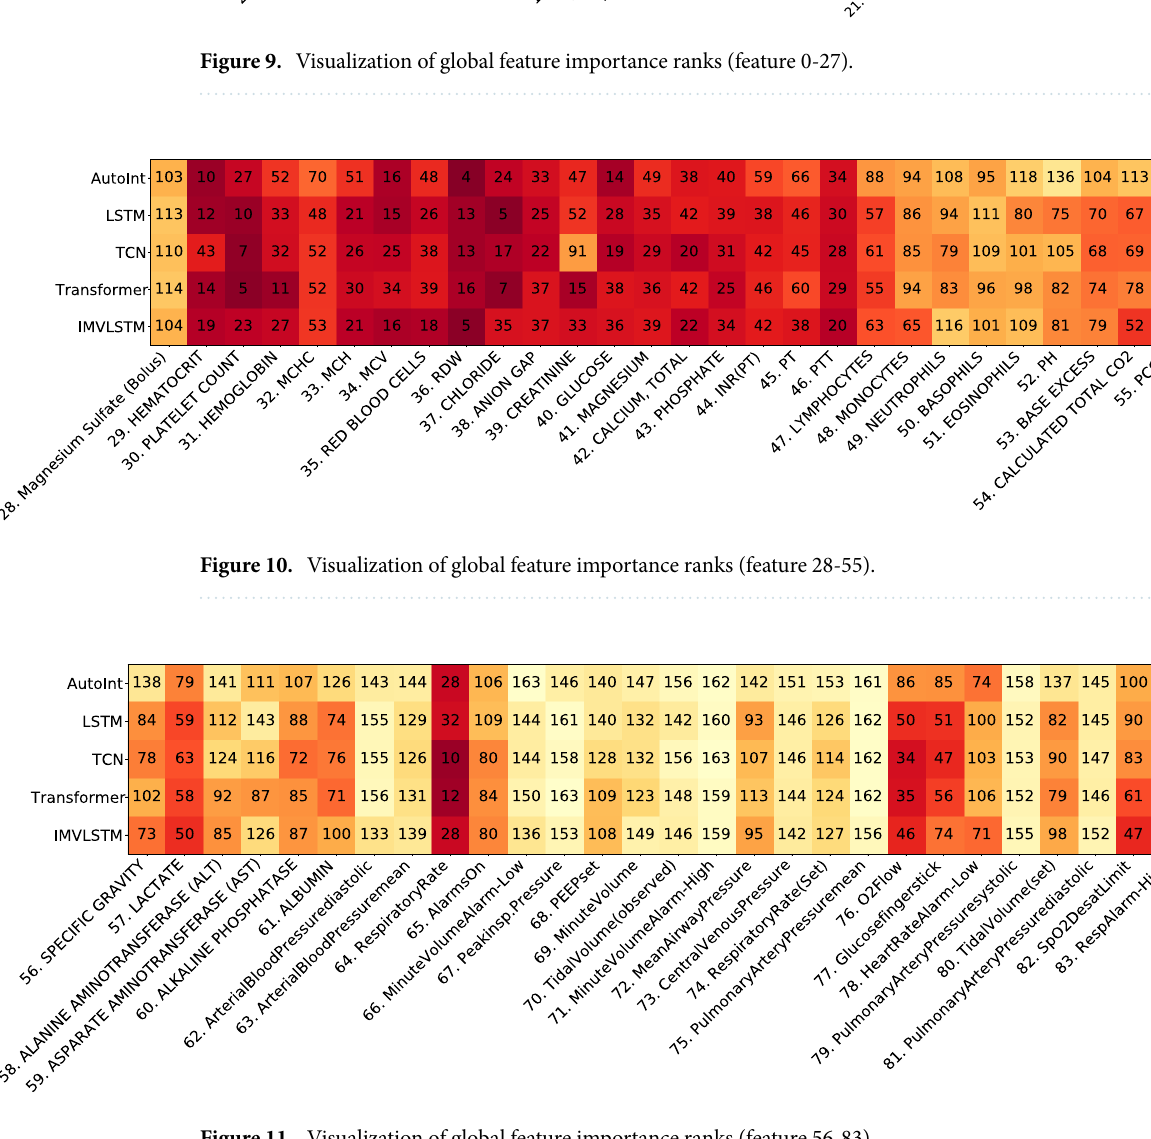
Figure 11. Visualization of global feature importance ranks (feature